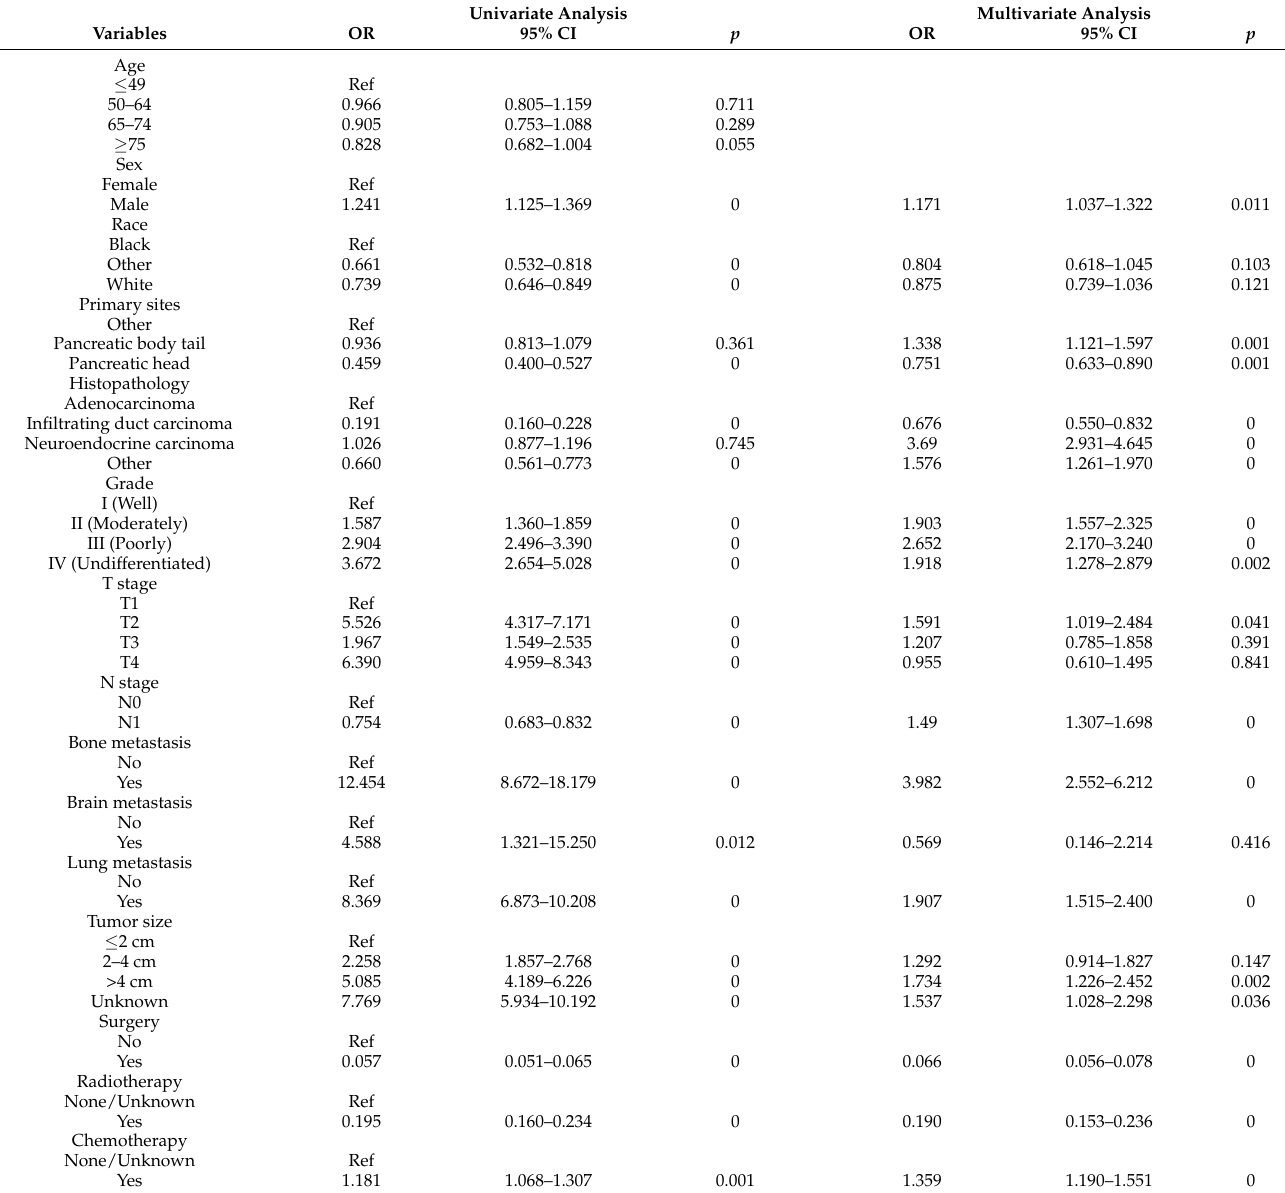
Table 2. Univariate and multivariate logistic regression analysis of the risk factors in patients of pancreatic cancer with liver